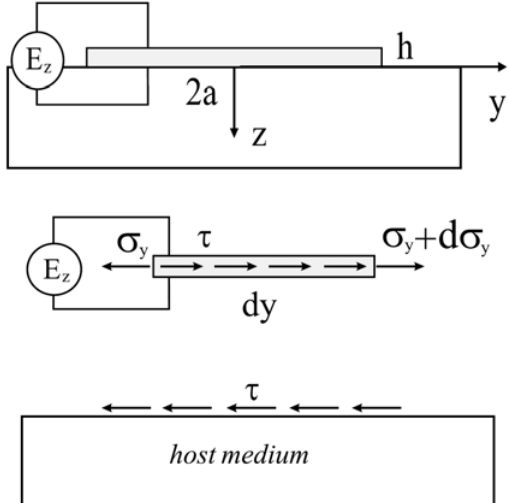
Figure 4. The actuator model with coupled piezo-elastodynamics. Taken from Huang and Sun